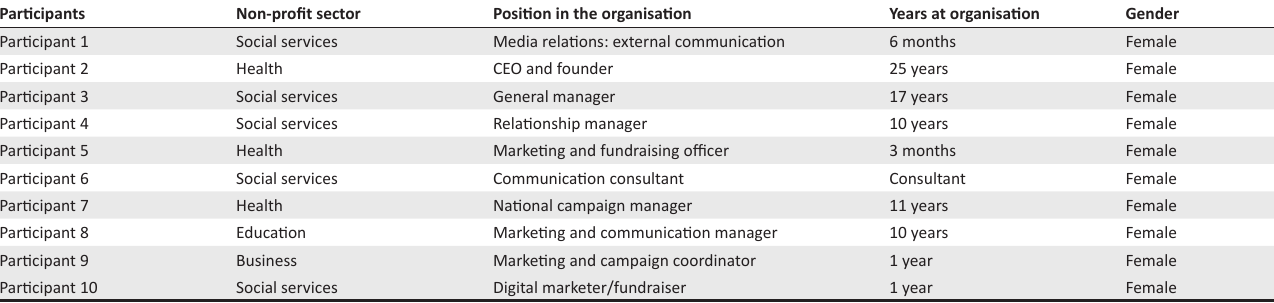
TABLE 3: Participants’ profiles (Swart